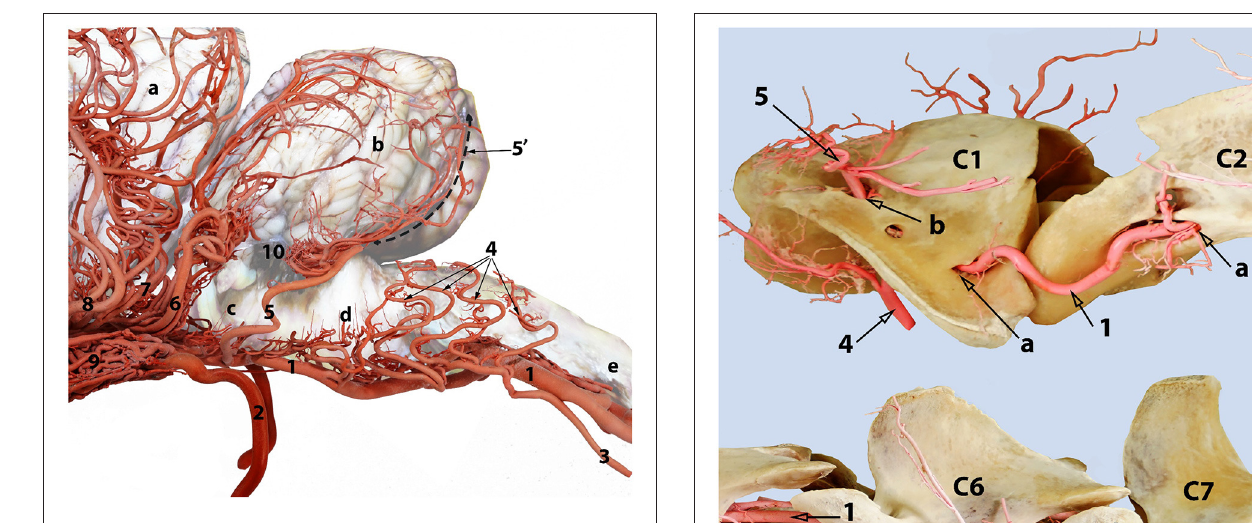
FIGURE 4 | A composite photograph showing the arterial supply to the caudal regions of the dromedary brain (left lateral view). 1, basilar artery; 2, internal carotid artery; 3, lateral branch of the vertebral artery; 4, medullary branches; 5, caudal cerebellar artery; 5’, dorsal arch of caudal cerebellar artery; 6, rostral cerebellar artery; 7, caudal choroidal artery; 8, caudal cerebral artery; 9, rostral epidural rete mirabile (RERM); 10, choroid plexus of the fourth ventricle; a, cerebrum; b, cerebellum; c, pons; d, medulla oblongata and e, spinal cord.